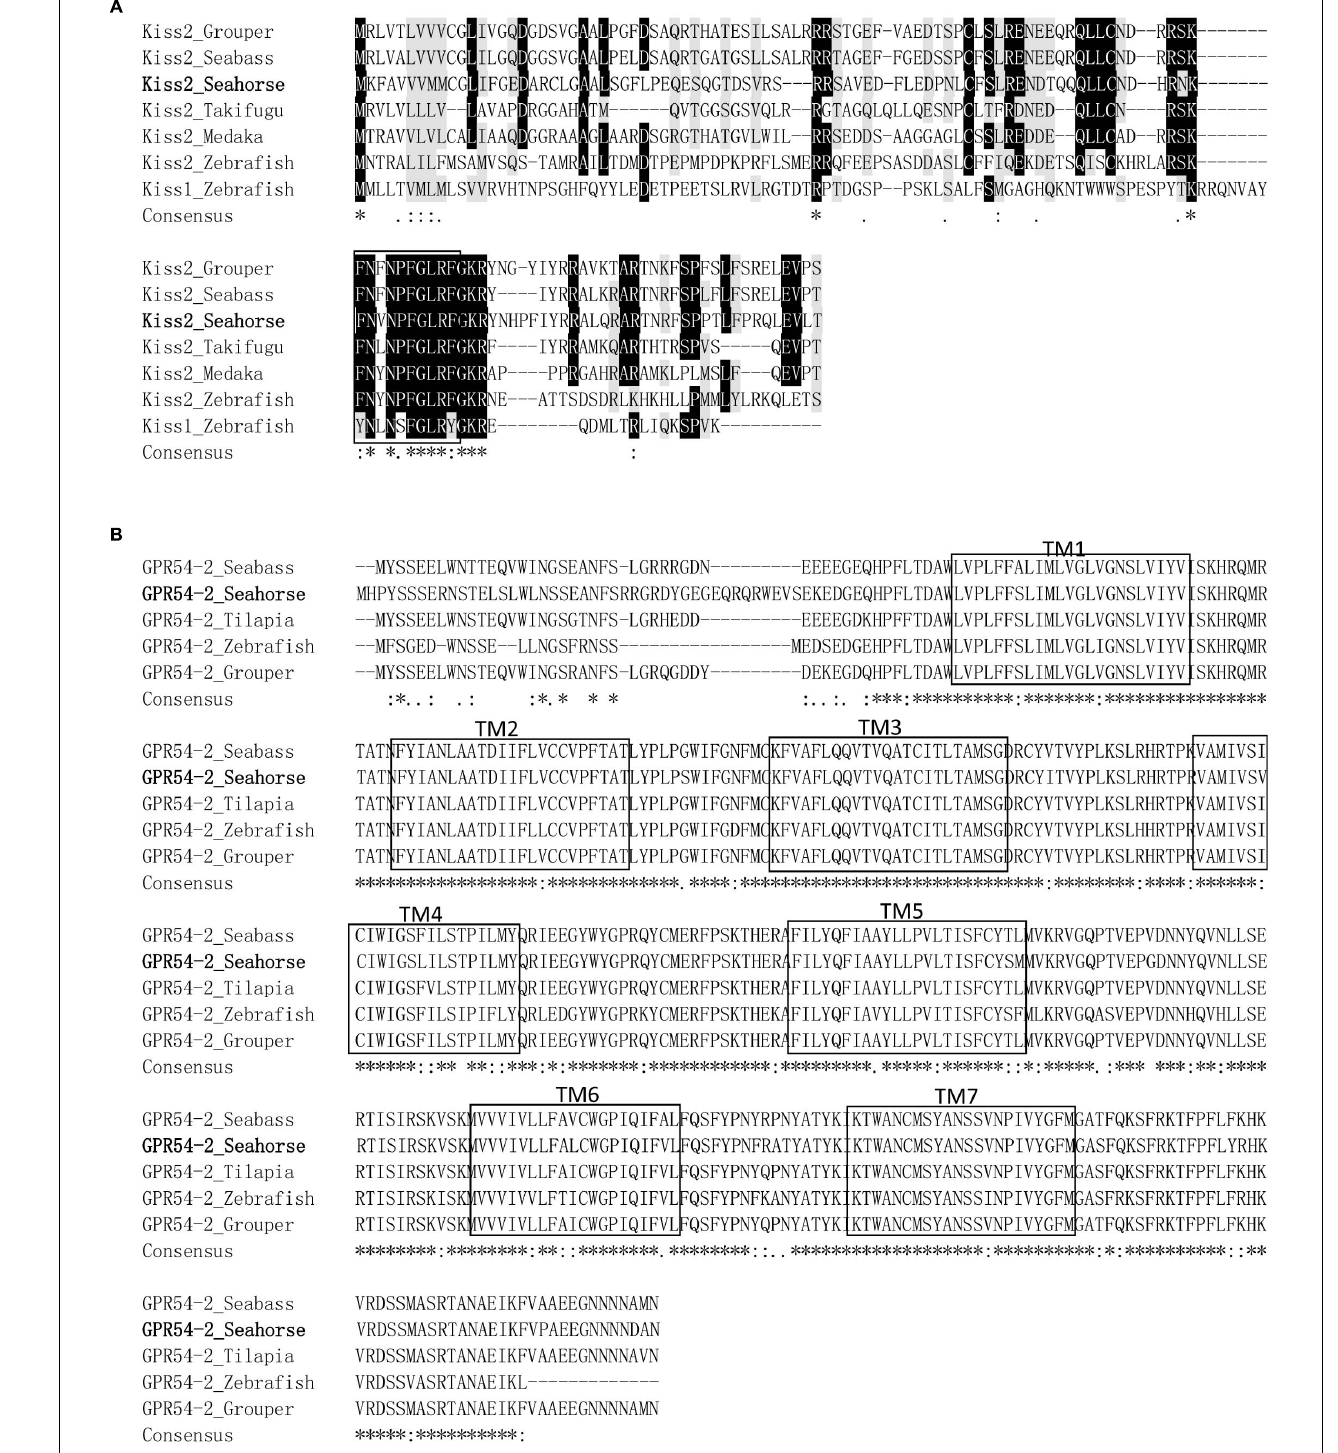
FIGURE 2 | Comparison of amino acid sequences of kisspeptin precursors and GPR54-2 from different species. (A) The mature peptides of Kiss2 are boxed. Multiple sequence alignment was performed by ClustalX 2.0. Identical sequences are indicated by asterisks. (B) Alignment of the amino acid sequences of GPR54-2 in different species. Gaps introduced in some sequences to maximize the alignment are indicated by hyphens. Identical sequences are indicated by asterisks. Putative TM domains are boxed. The GPR54-2 sequences of other teleosts were downloaded from GenBank (For detailed, see the legend for Figure 3 ).